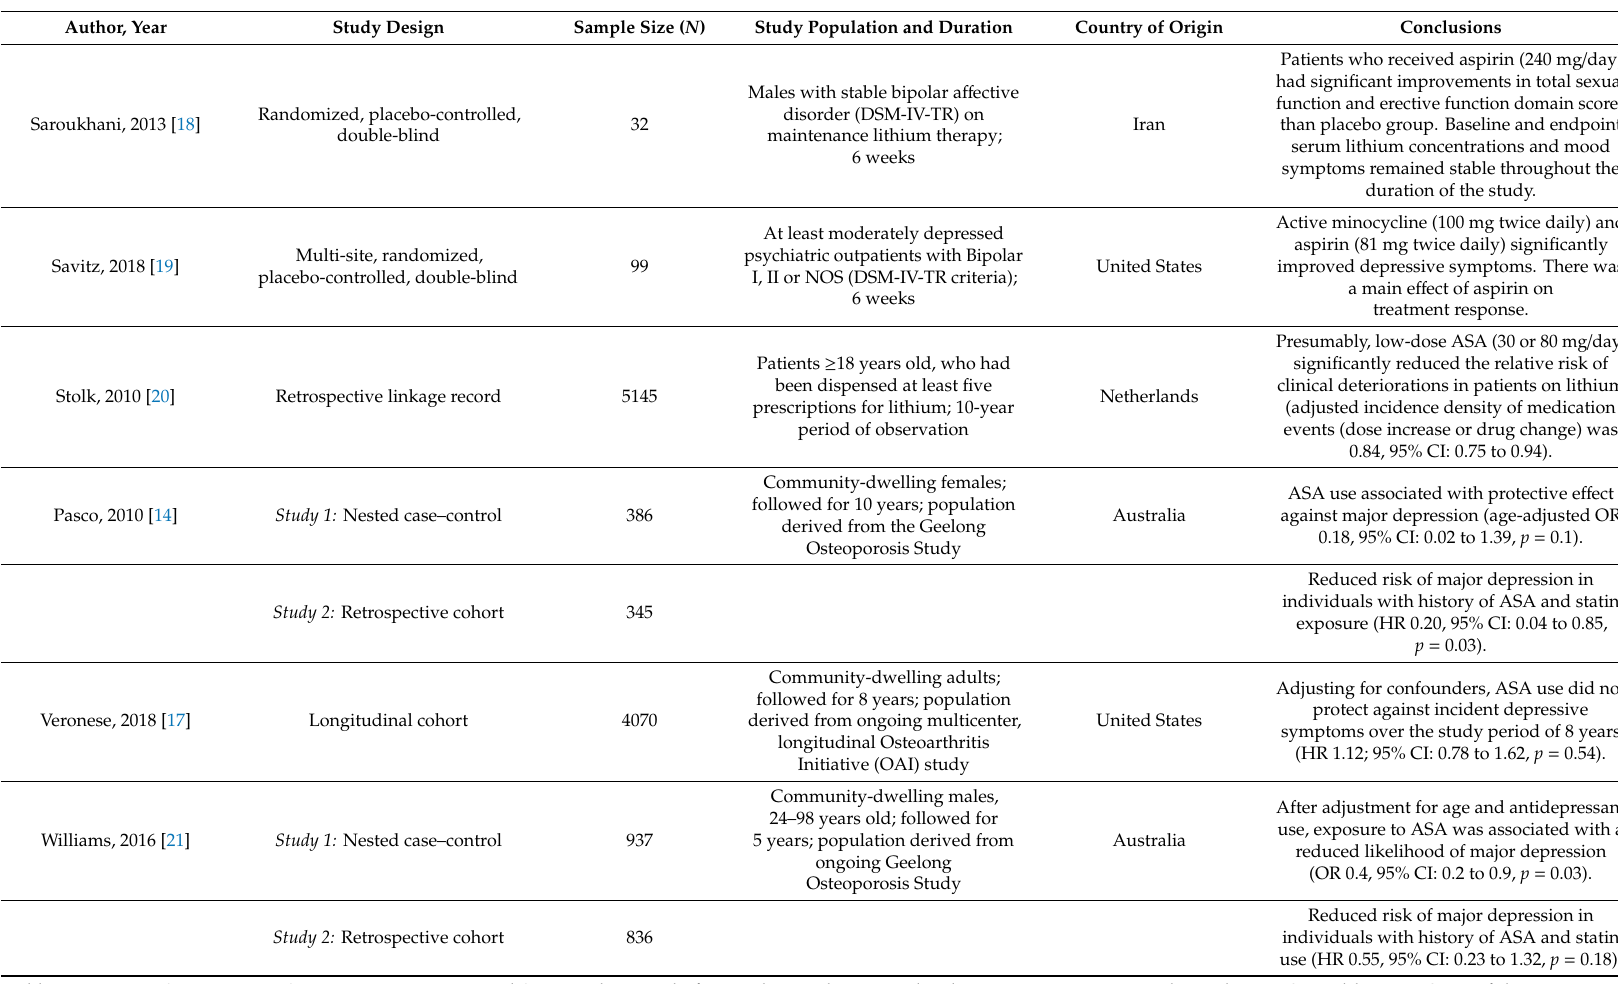
Table 1. Clinical studies investigating the e ff ects of acetylsalicylic acid (ASA) on mood disorders (arranged alphabetically by first author’s last